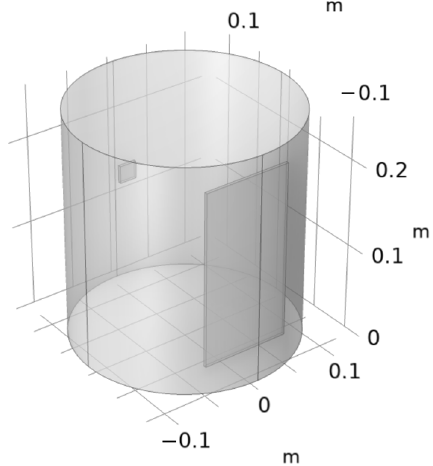
Figure 2. Simplified geometric model.